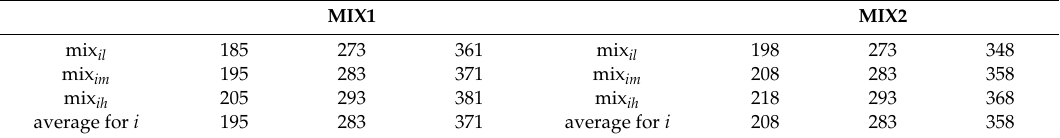
Table A13. Revised dental charges in monetary units to maintain markup (of the mixes and therefore totalled) constant for the 9 mixes under consideration in the two mix scenarios (MIX1 and MIX2). MIX1